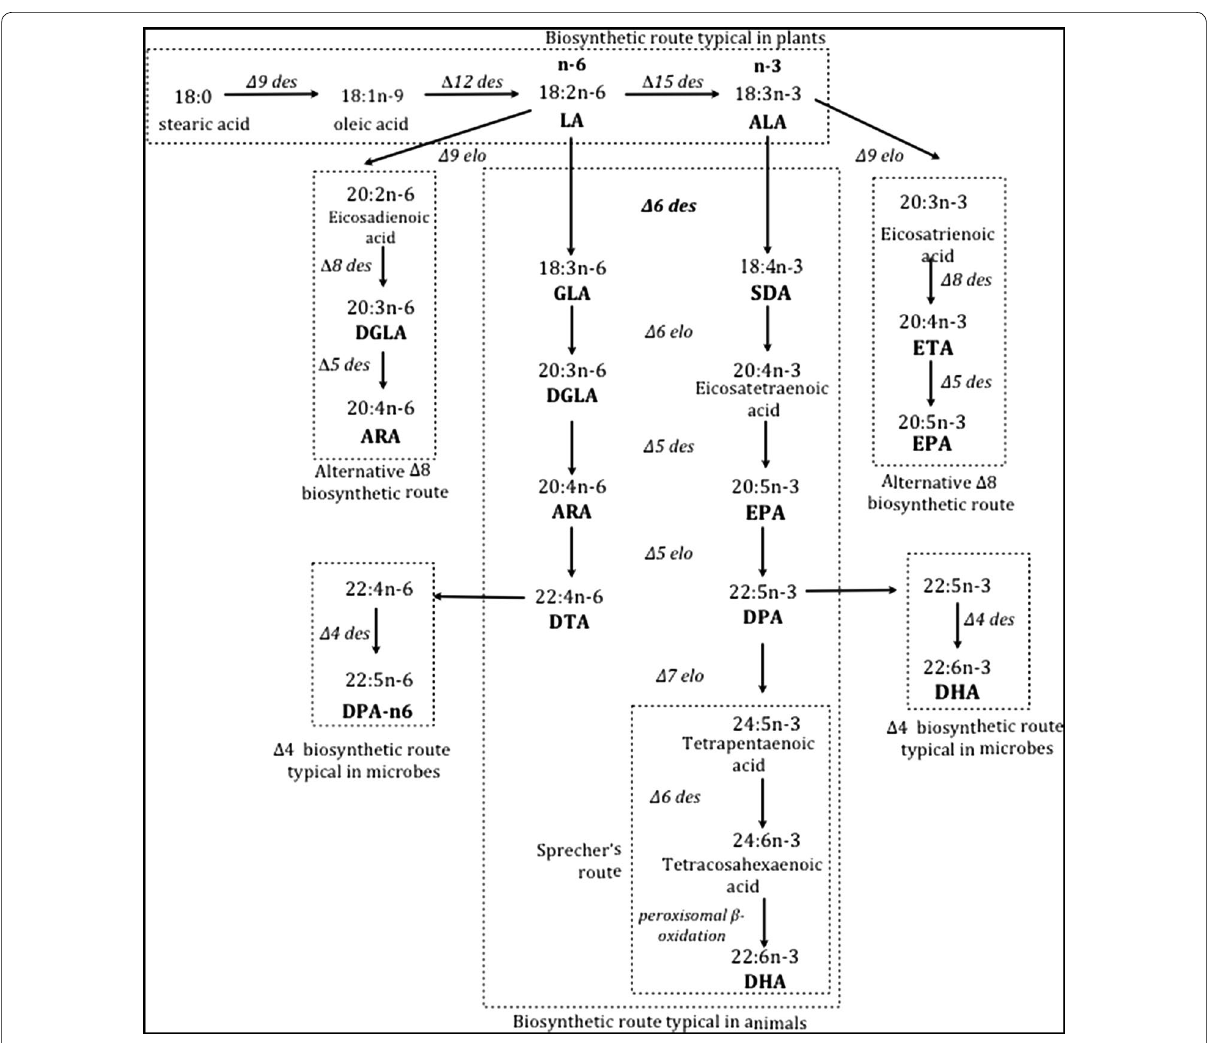
Fig. 1 Biosynthetic route of fatty acids requiring the essential LA (linoleic acid) and ALA (alpha‑linolenic acid) with the different variations and steps. des desaturase, elo elongase; ARA (arachidonic acid), DGLA (dihomo‑gamma linolenic acid), DHA (docosahexaenoic acid), DPA (docosapentaenoic acid), DTA (docosatetraenoic acid), EPA (eicosapentaenoic acid), ETA (eicosatetraenoic acid), GLA (gamma‑linolenic acid), SDA (stearidonic